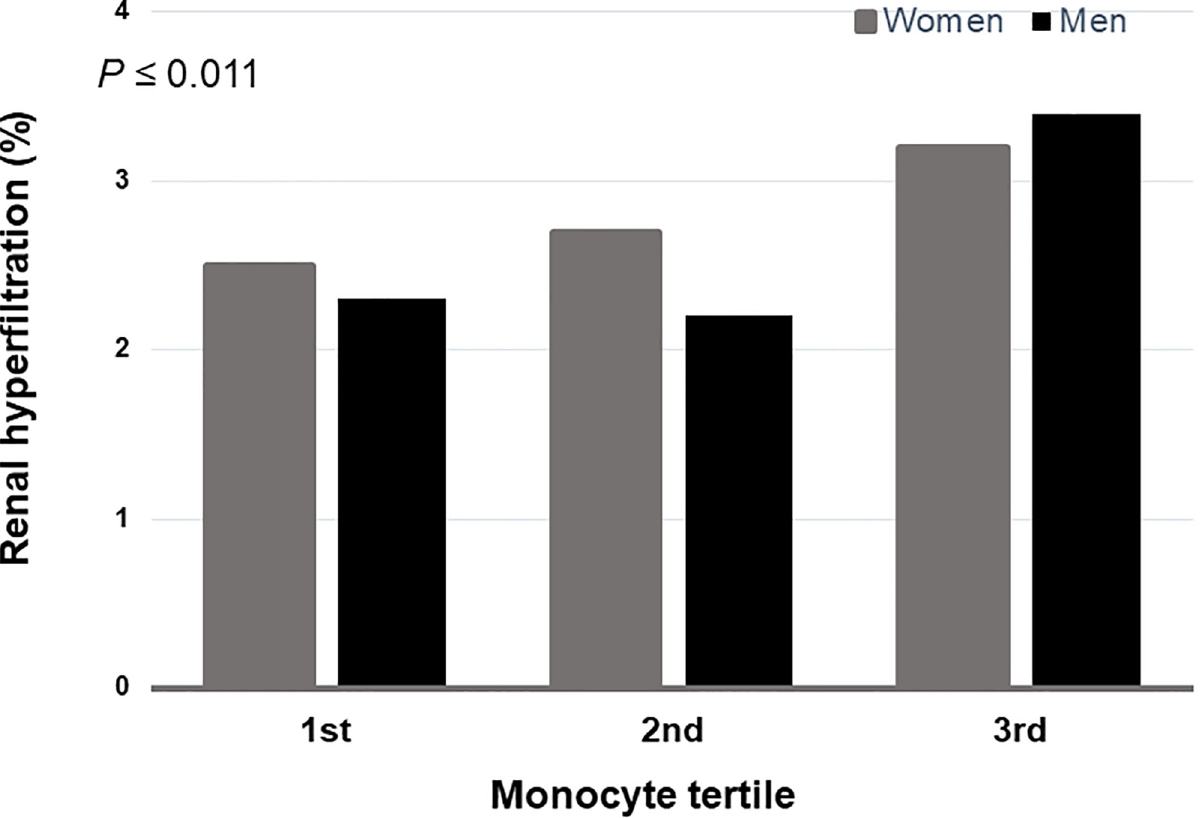
Fig 3. The prevalence of renal hyperfiltration (RHF) stratified by monocyte count tertiles. The highest monocyte tertile was most frequent in RHF both men and women ( P � 0.011).